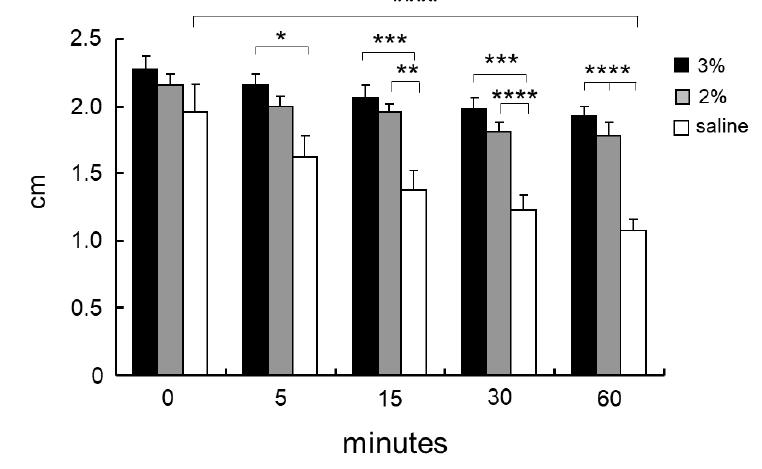
Figure 6. Lifting effect of CH-LA-S. A solution of 3% CH-LA-S (black columns), 2% CH-LA-S (gray columns), or physiological saline (white columns) was injected into the submucosa of ex vivo porcine stomach, and the heights of injection volumes were measured at the indicated time point over the subsequent hour. Data are plotted as mean ± SD (n = 5). * p < 0.05, ** p < 0.01, *** p < 0.005, and **** p < 0.001 by Tukey post-hoc test. Reprinted from [27], Copyright 2017, with permission from Elsevier.